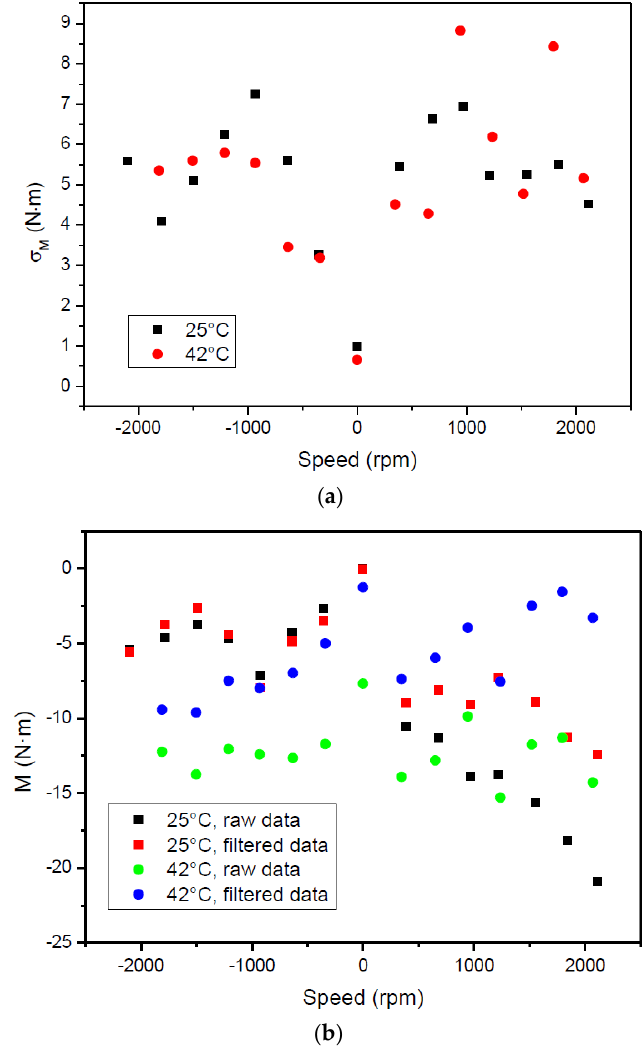
Figure 12. ( a ) Standard deviation and ( b ) torque measured at different rotation speeds. Black and green data points: values calculated with all frequency readings. Red and blue data points: values calculated with frequency readings that fall within the standard deviation.